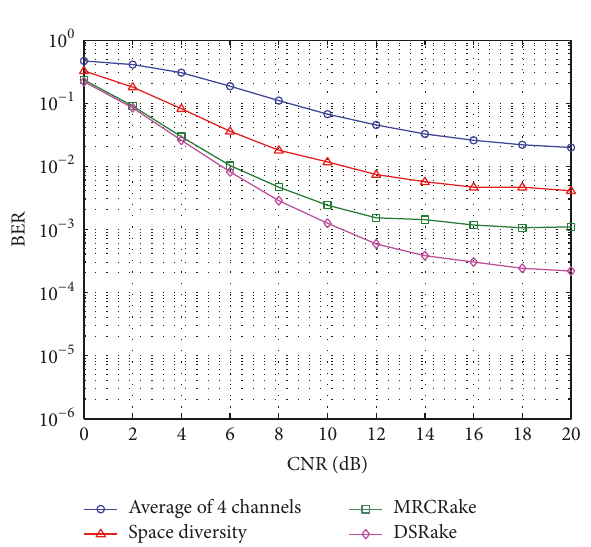
Figure 19: BER results for 20m